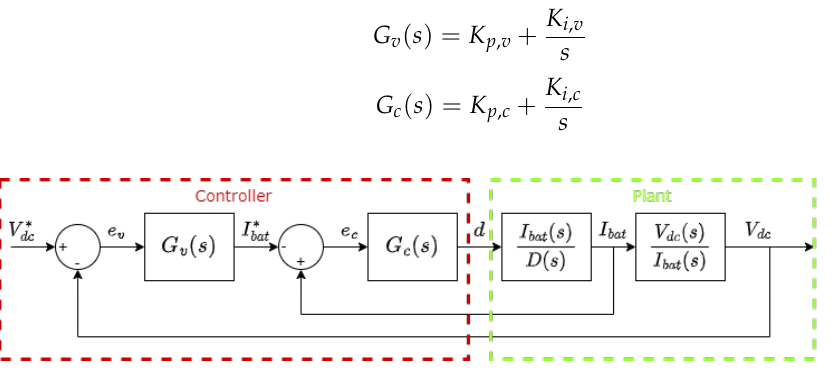
Figure 3. Block diagram of the bidirectional boost converter